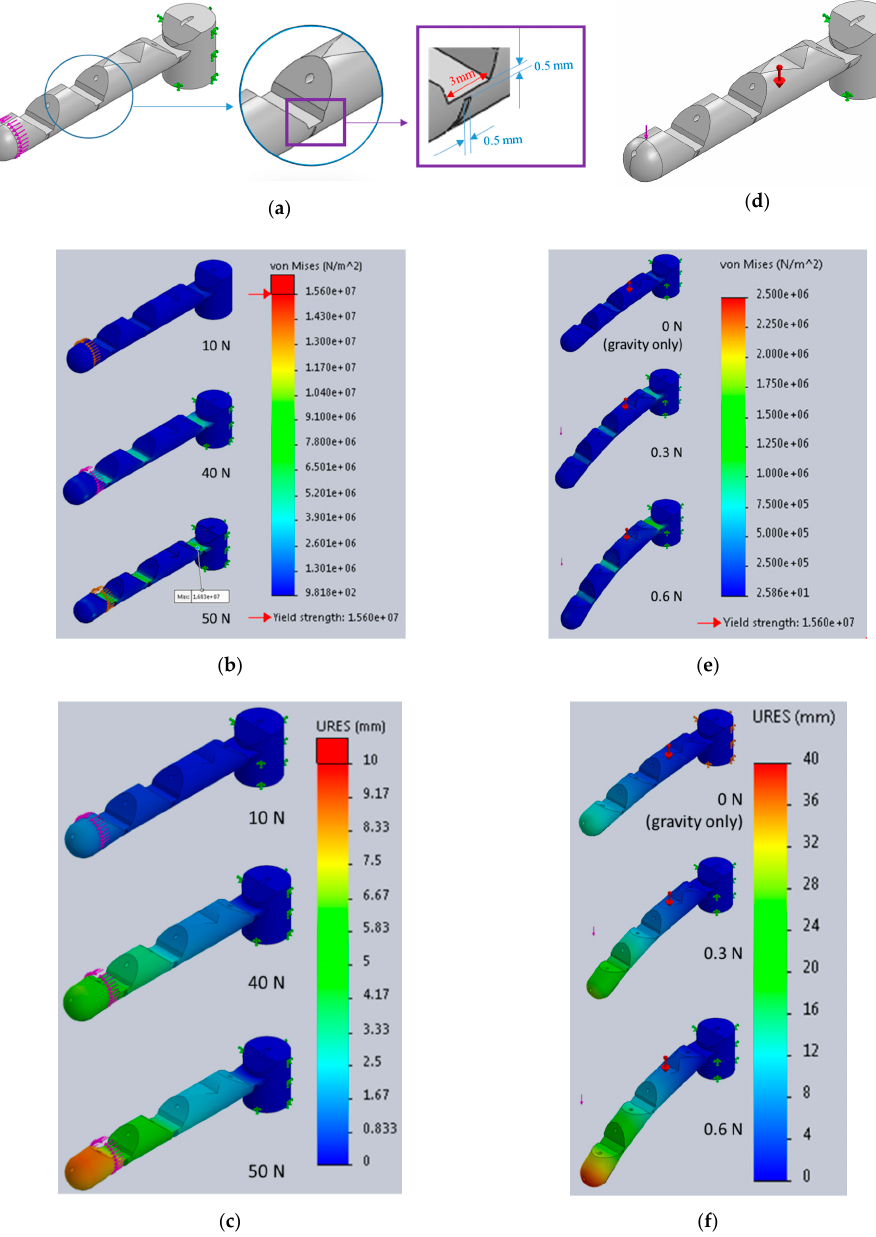
Figure 12. Static stress simulation for axial ( a – c ) and perpendicular ( d – f ) loading: ( a , d ) loading and boundary conditions of finger, ( b , e ) resultant stress and ( c , f ) resultant displacement.